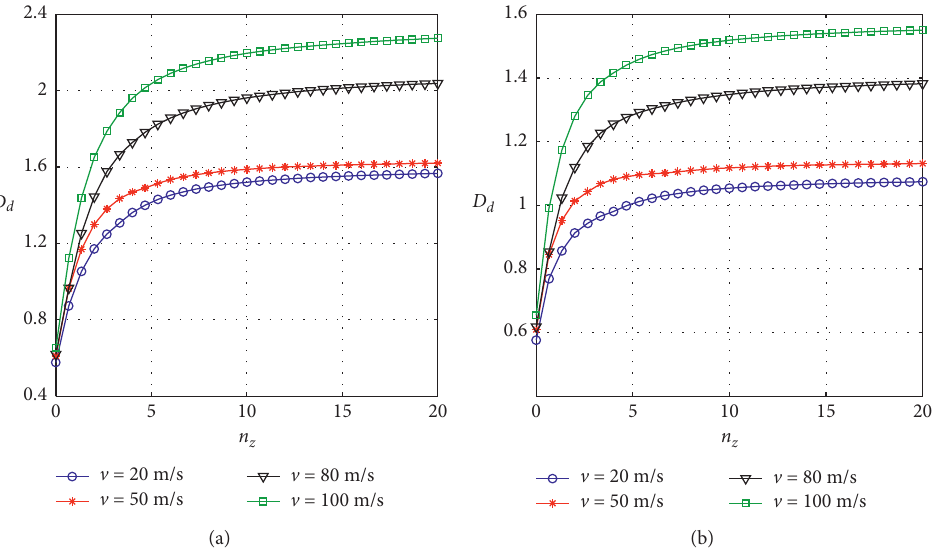
Figure 6: Grading index n